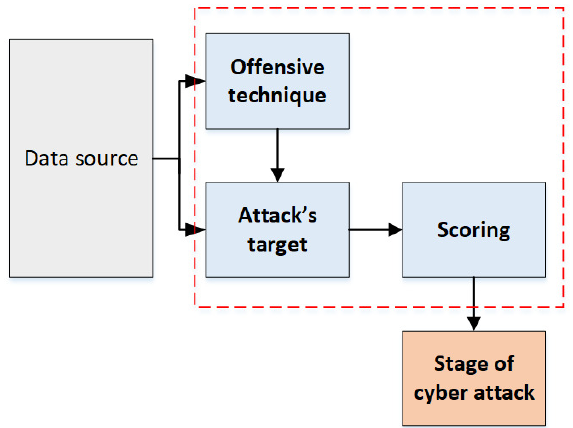
Figure 2. Identification of stages of cyberattack by scoring offensive techniques to attack’s target (based on